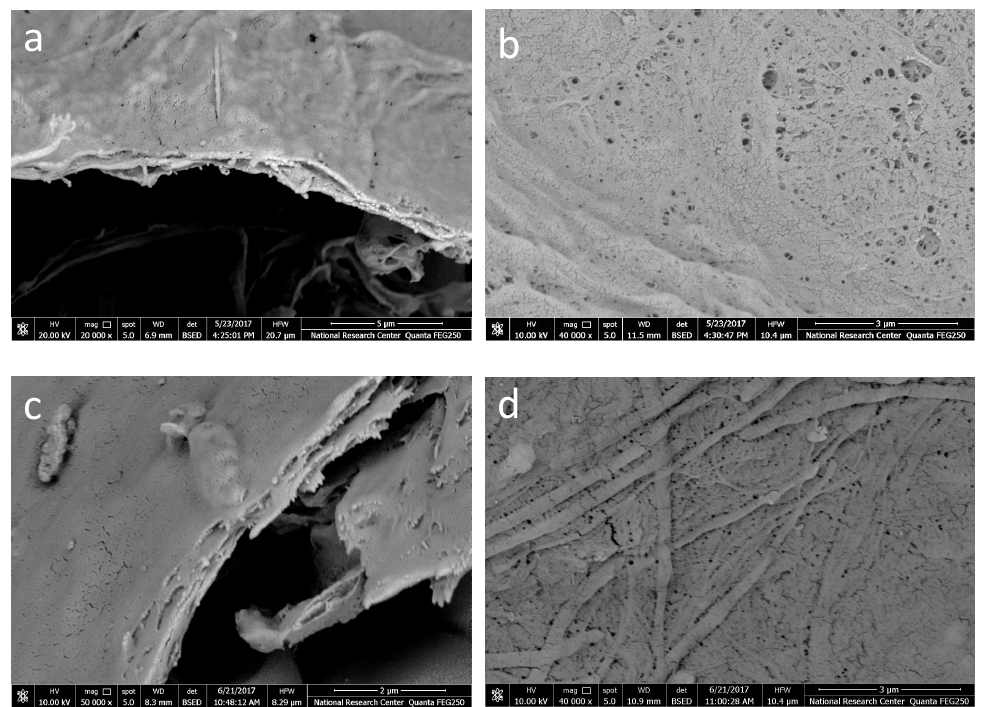
Figure 4. SEM images of cross section and surface of the alcohol-exchanged CNF membranes ( a , b ) and the CNF/AC membranes ( c , d ) formed on hardened filter paper.